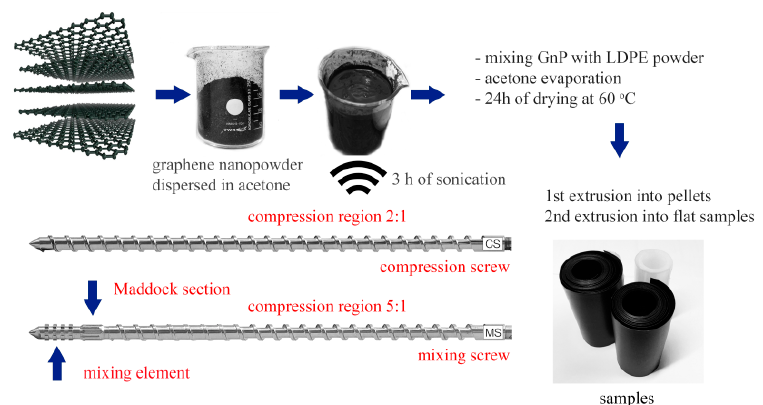
Figure 1. Scheme illustrating samples preparation process.